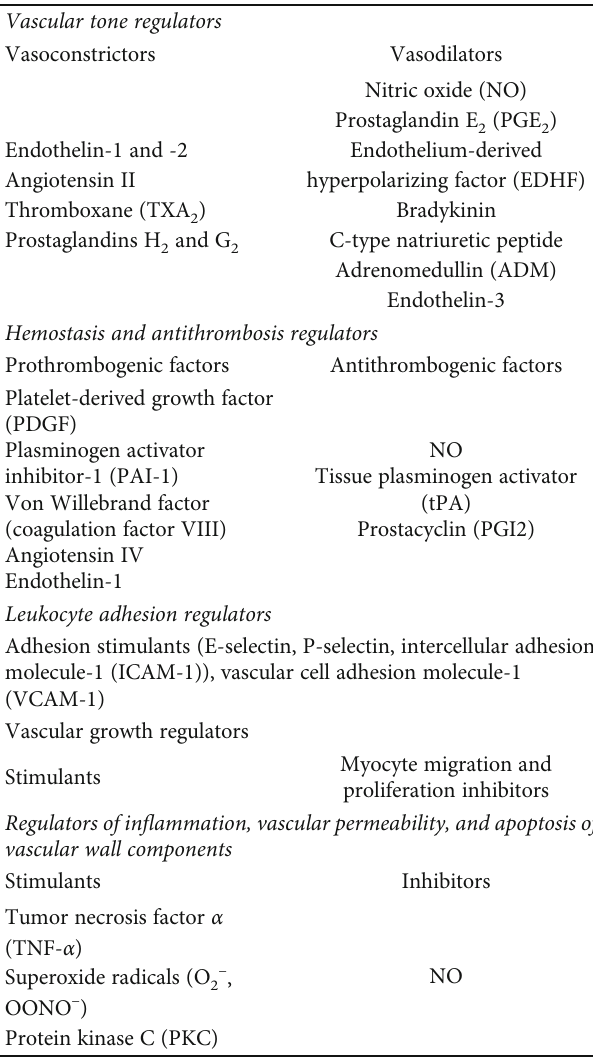
Table 1: Physiologically active substances and the circulatory system regulators synthesized in the